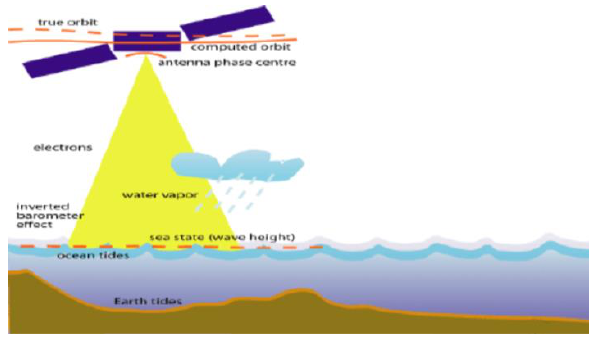
Figure 2. Corrections for altimeter range measurements Corrected range (